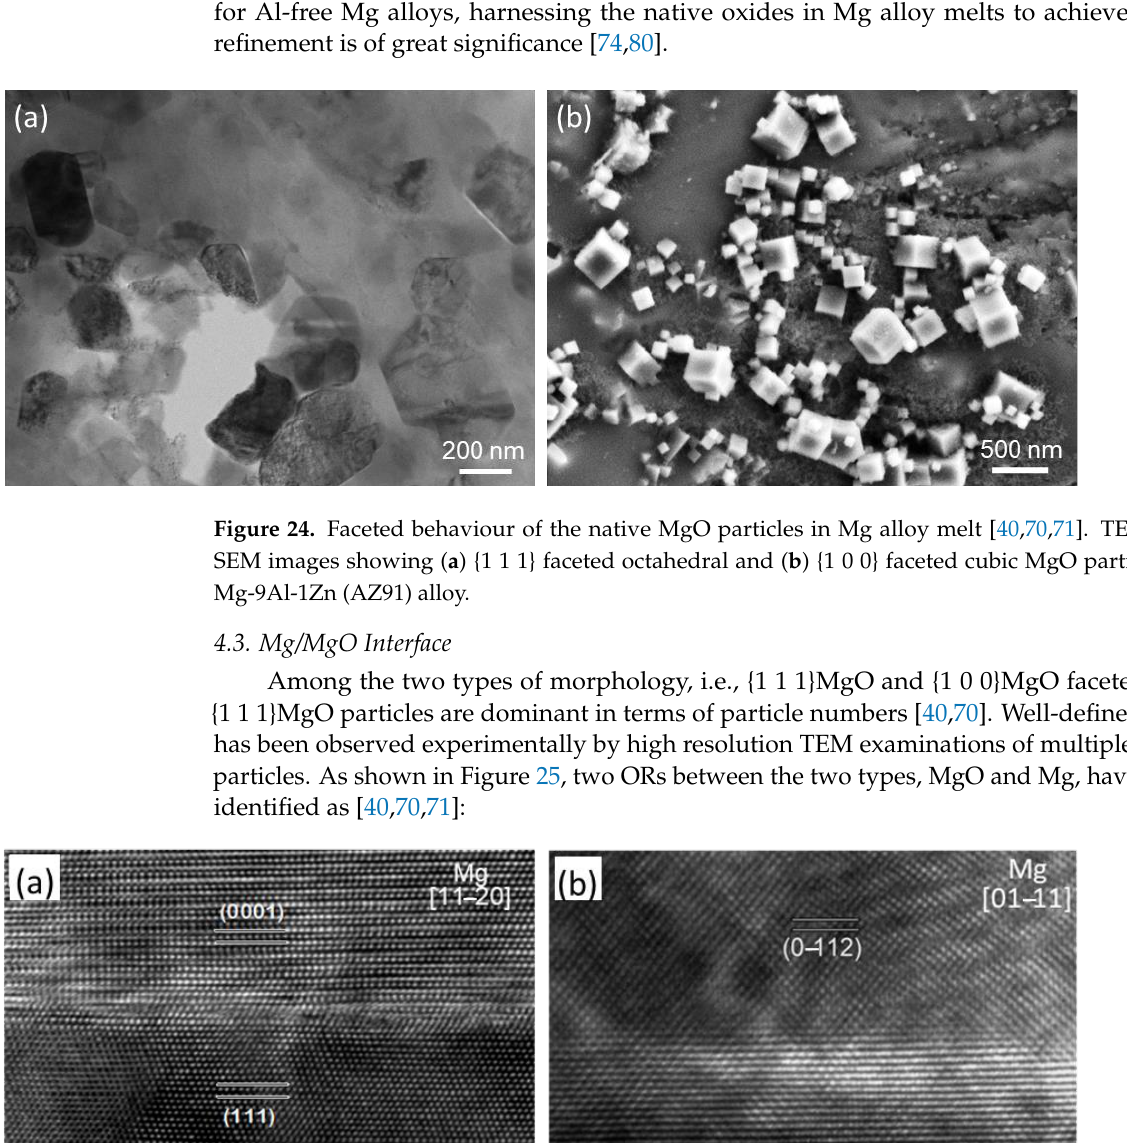
Figure 23. Morphology of MgO films and MgO particles [70]. SEM images showing general morphology of ( a , b ) native MgO films and ( c , d ) native MgO particles dispersed by melt shearing collected from ( a , c ) Mg-9Al and ( b , d ) commercial purity Mg melt. The oxide films are liquid films that contain numerous discrete MgO particles.